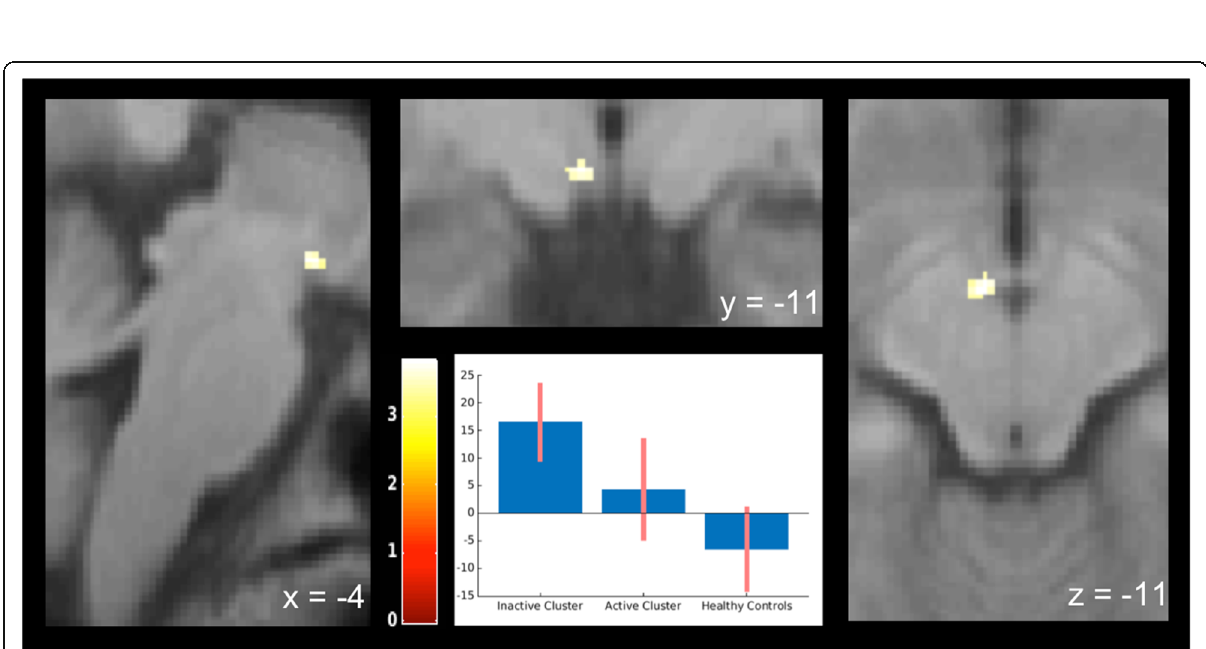
Fig. 2 T-score map of the second level anova, contrast inactive cluster headache > controls. Visualization threshold p < 0.001. Significant activation ( p < 0.05, small-volume-FWE-corrected) was observed within the posterior hypothalamus ipsilateral to the site of cluster headache and trigeminal nociceptive stimulation (x = − 4, y = − 11, z = − 11, T = 3.80, k = 12 voxels). The bar plot indicates contrast estimates and 95%- confidential intervals for the three groups at the maximum of posterior hypothalamic